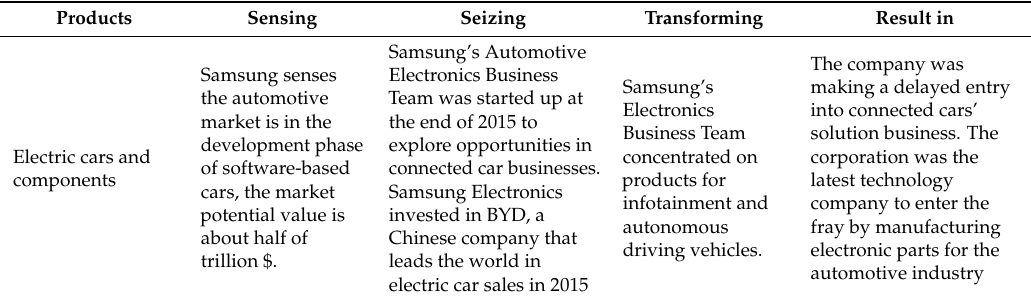
Table 1. Dynamic capabilities at Samsung to develop electric cars and its components before the acquisition of Harman.